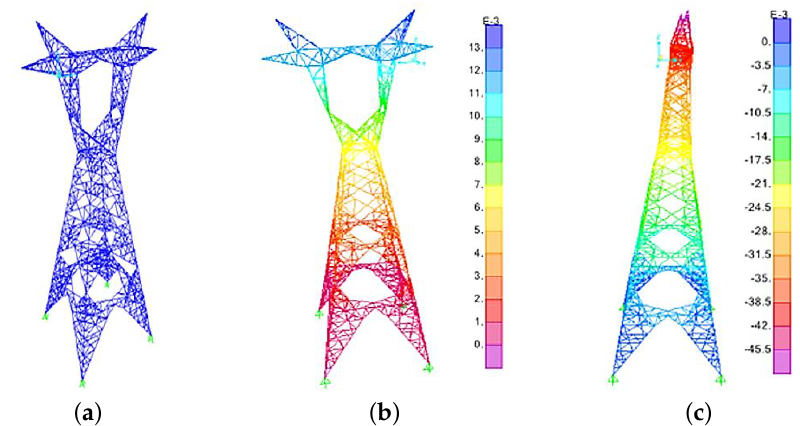
Figure 5. Numerical model and anatomy of vibration. ( a ) Finite element model; ( b ) First mode in latitudinal direction; ( c ) First mode in longitudinal